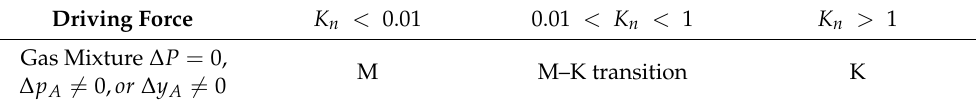
Table 5. Influence of the Knudsen number on a mass transfer through a porous medium. Driving